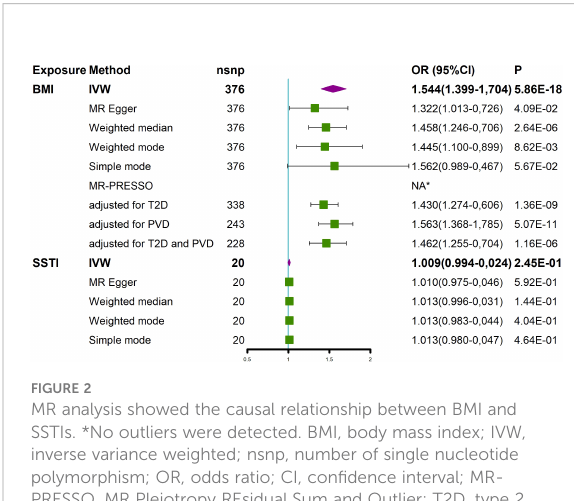
SSTIs. *No outliers were detected. BMI, body mass index; IVW, inverse variance weighted; nsnp, number of single nucleotide polymorphism; OR, odds ratio; CI, con fi dence interval; MR- PRESSO, MR Pleiotropy REsidual Sum and Outlier; T2D, type 2 diabetes; PVD, peripheral vascular disease; SSTI, skin and soft tissue infection.